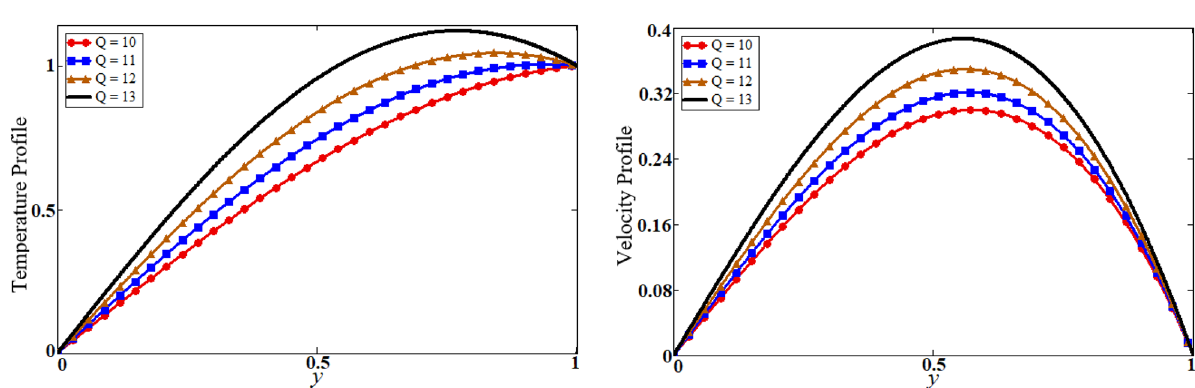
Figure 7. The shape effect of nanoparticles on temperature and velocity.